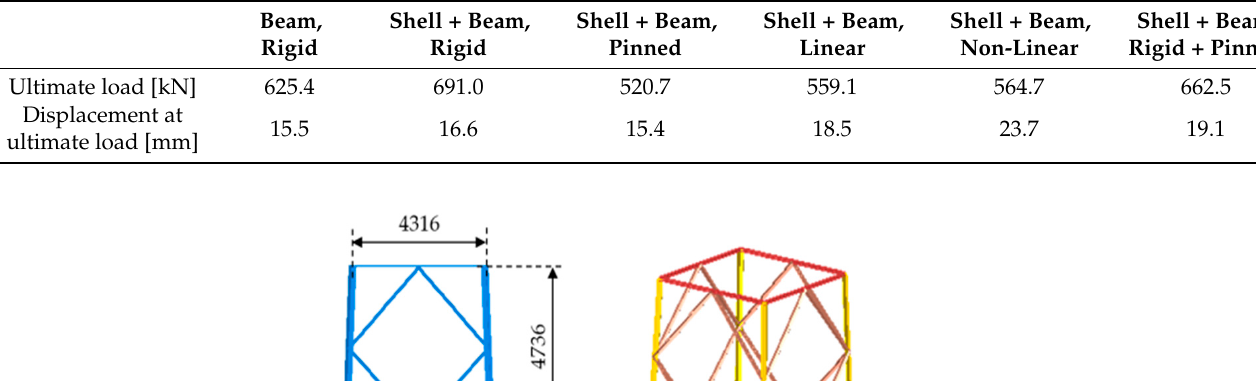
Table 6. Load capacity of the 3D-subassembly models compared.